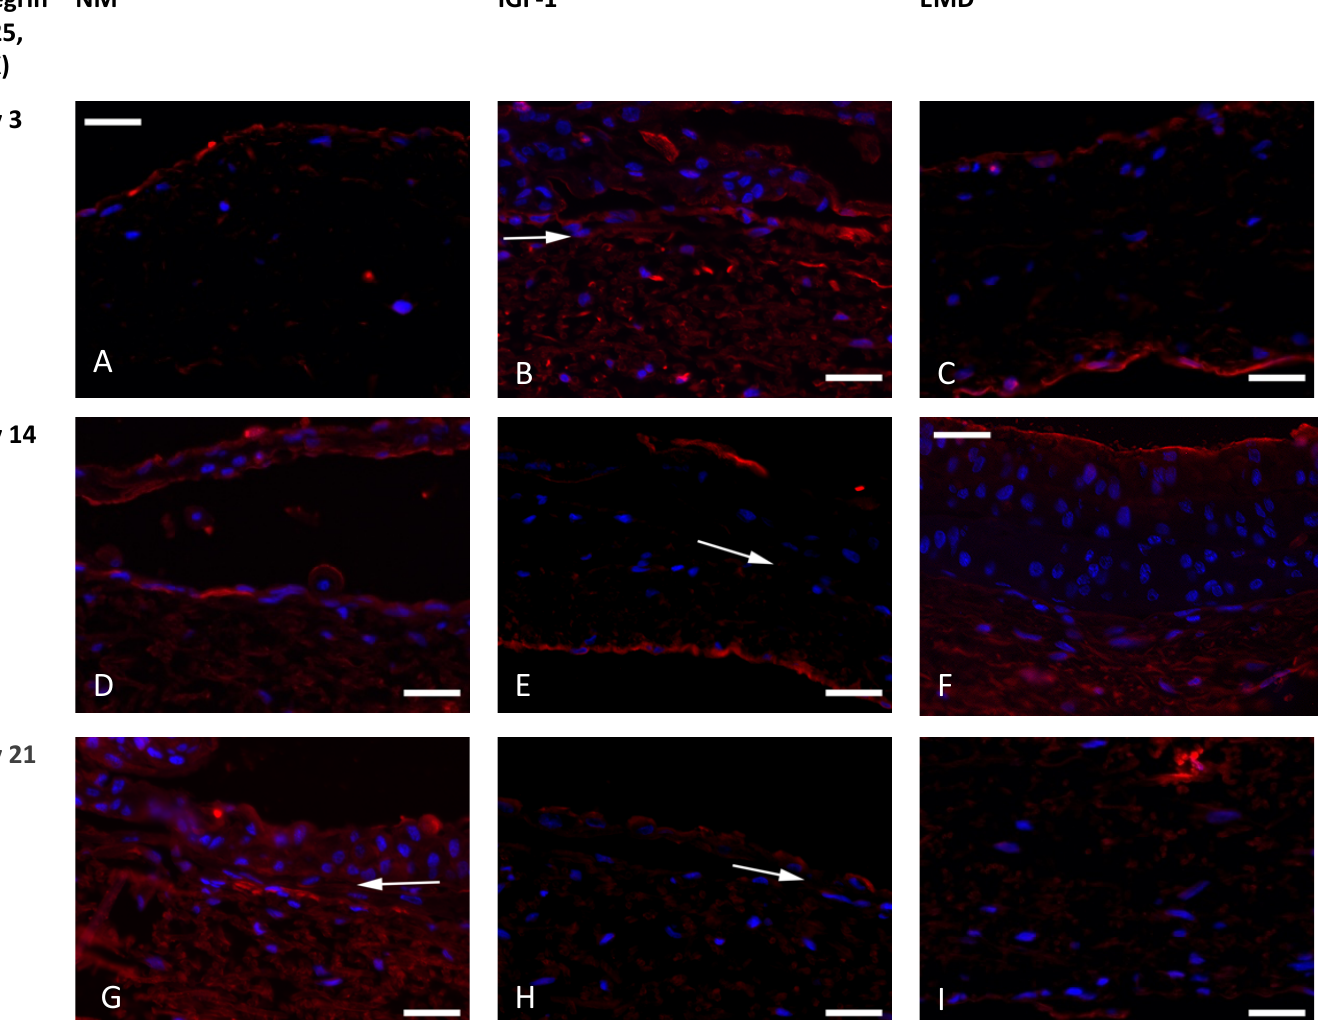
Figure 3. LocaKon and interacKons of dental cells as assessed by immunofluorescent staining. Immunofluorescent staining for anW-integrin 1 (red) at Days 3 (A-C), 14 (D-F) and 21 (G-I) in constructs cultured in NM (A, D & G), IGF-1 (B, E, H) and EMD media (C, F & I). Note the abundant cell-cell contact between pDE and hDM cells throughout several of the constructs (arrows)(scale bar =